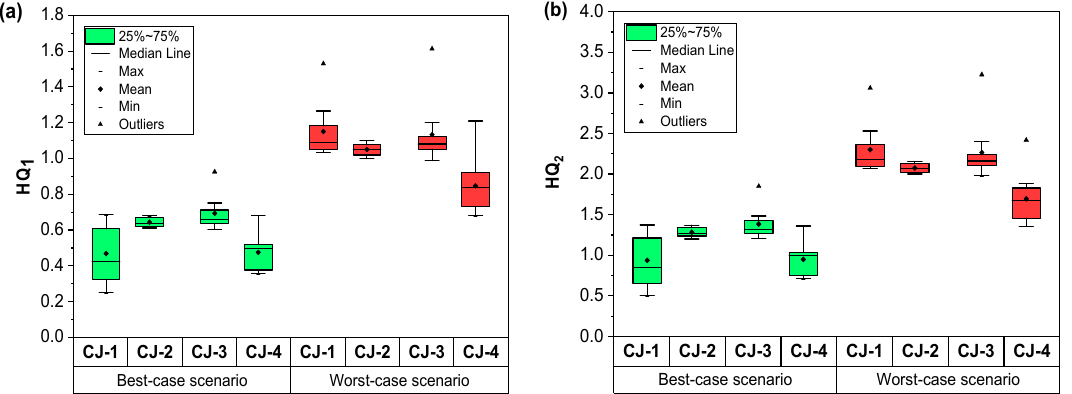
Figure 5. Variation of hazard quotient ( HQ ) calculated based on EU limit values ( a ) and World Health Organization air quality guidelines ( b ) between the air quality monitoring stations in Cluj-Napoca city.